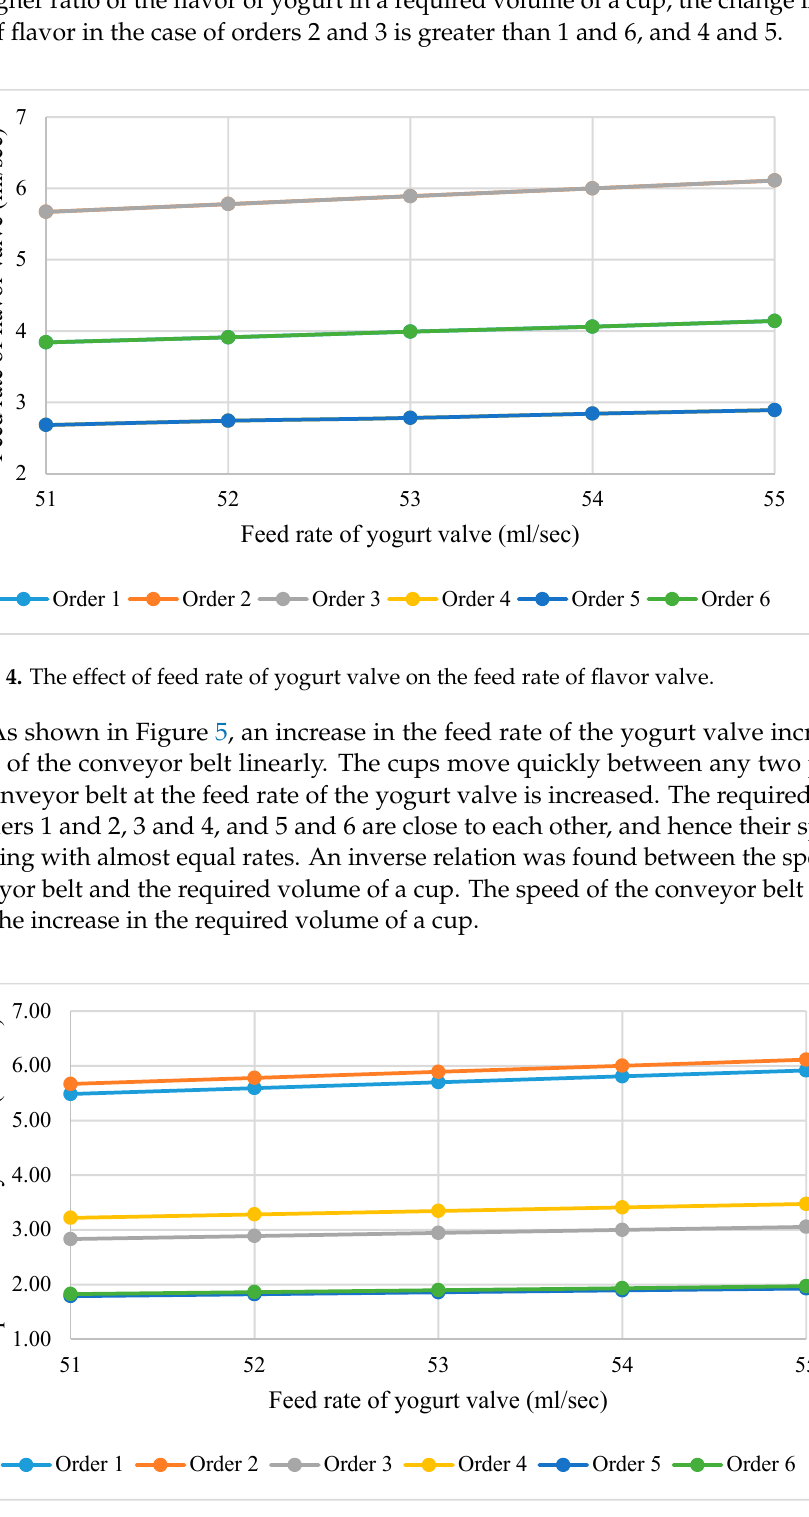
Figure 5. The effect of feed rate of yogurt valve on the speed of conveyor belt. To increase the feed rate of the yogurt valve, the waiting time of the last cup of an order for processing decreases linearly, as can be seen in Figure 6. There is a higher decrease per unit change in the feed rate of the yogurt valve in orders 1 and 6 compared to the other orders. In the case of order 1, compared to other orders, time depends on the required number of cups and volume. The decrease in time per unit change in the feed rate of yogurt for all other orders are is almost the same.